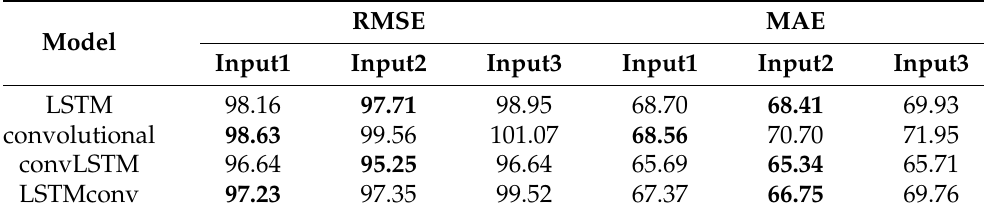
Table 3. Comparison of different input factors of Ulm data for the NNs. The table shows the RMSE values in Wh/m 2 . The best results are marked in bold